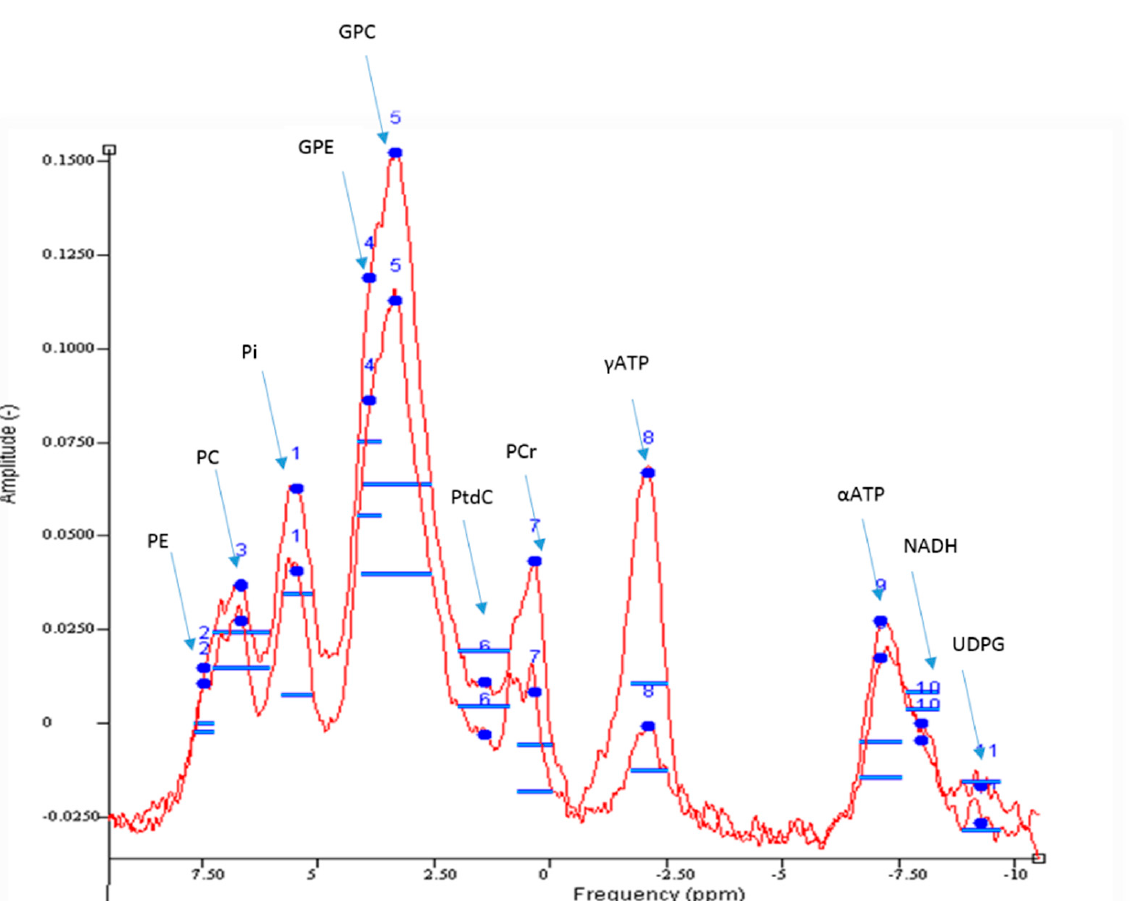
Figure 7. Example 31 P MR Spectrum acquired from the liver at 3T. Good spectral resolution enables quantification of phosphorus metabolites including adenosine triphosphate (ATP), phosphomonoesters (phosphocholine, PC and phosphoethanolamine, PE), phosphodiesters (glycerophosphocholine, GPC and glycerophosphoethanolamine, GPE), nicotinamide adenine dinucleotide (NADH), uridine diphosphate glucose (UDPG) and phosphatidylcholine (PtdC).